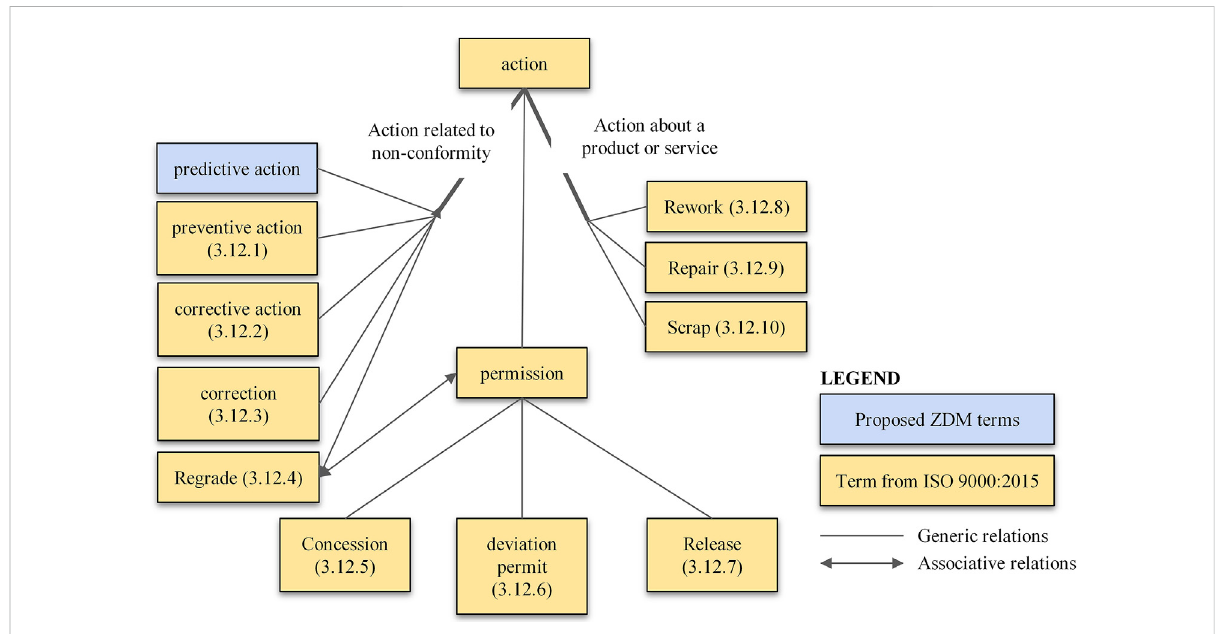
FIGURE 8 Some concepts related to action and the relation to ZDM terms [adapted from (ISO, 2015b)]. Terms collected from ISO 9000:2015 include the entry number in that standard for better reference and